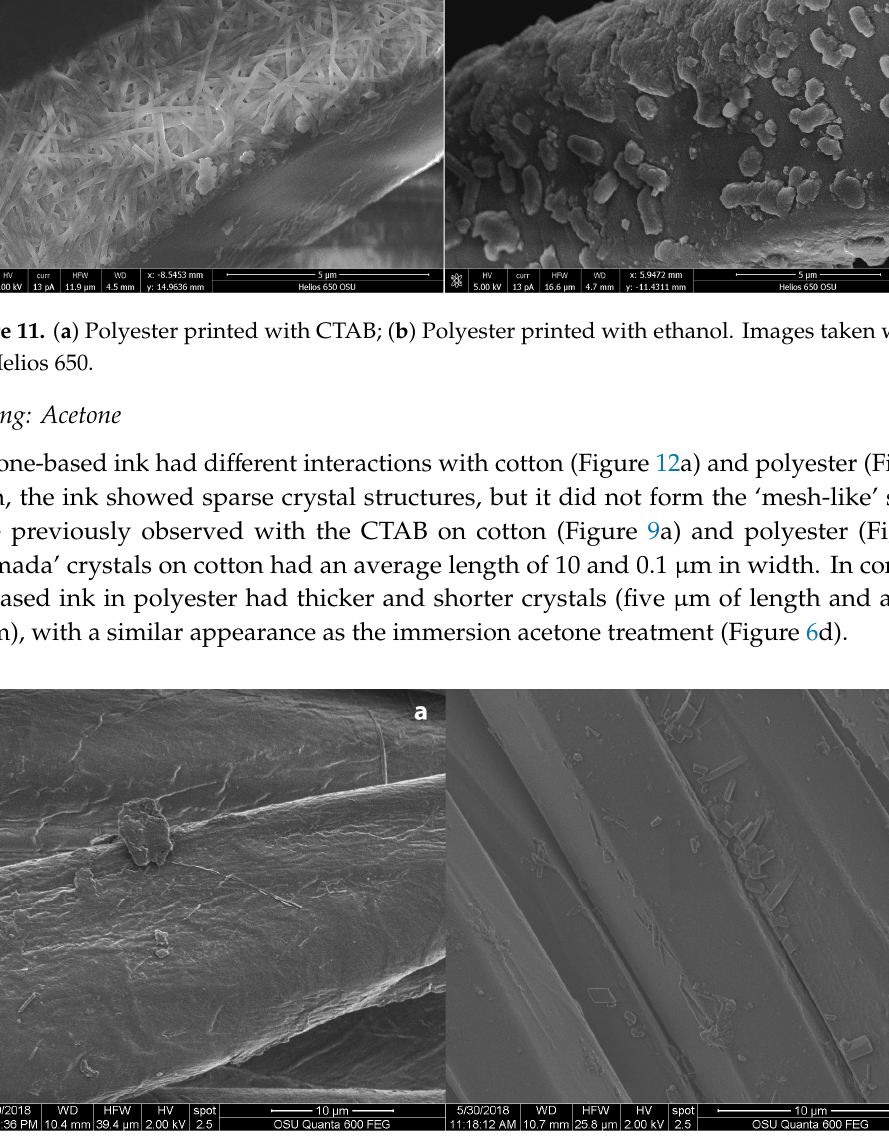
Figure 12. ( a ) Cotton printed with acetone-based ink; ( b ) Polyester printed with acetone-based ink. Images taken with a FEI Quanta 600.